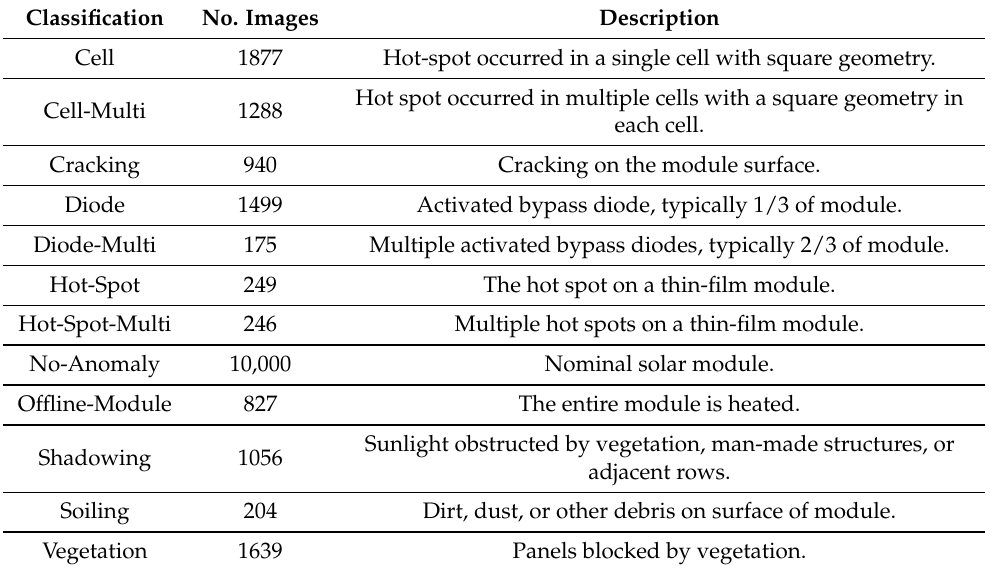
Table 2. Dataset